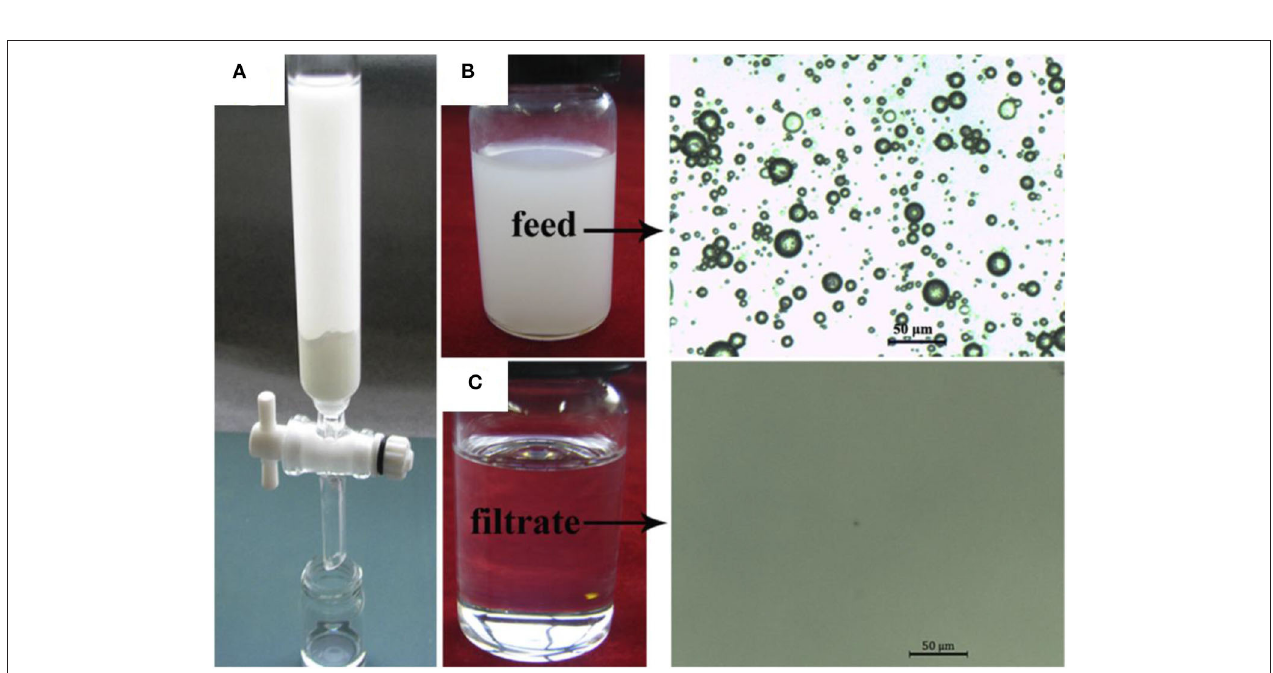
FIGURE 9 | (A) Digital images showing the setup for separation of water-in-oil emulsion. Optical microscope results of water in toluene emulsion before (B) and after (C) separation. Adapted from Li et al. (2017c). With permission from Elsevier, copyright 2017.